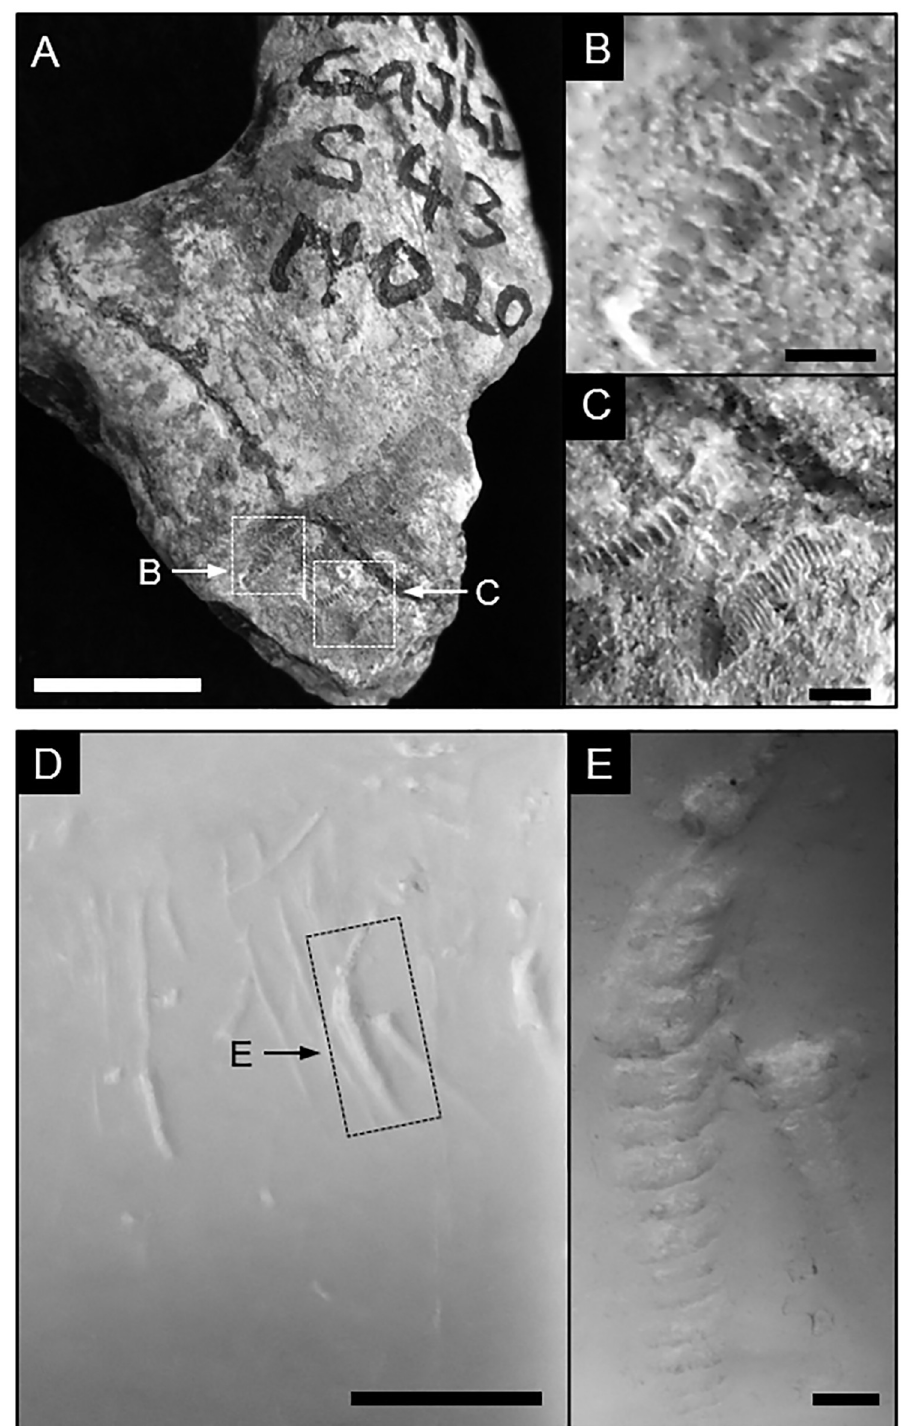
Fig 1. Archived bone fragment (Sample ID—LA91-S43#020) imaged with a digital camera. Sample was recovered from the Lokalalei 1 archaeological site, West Turkana, Kenya, and contains unintentionally induced markings from air-scribe preparation techniques. A) scale bar = 1.0 cm; B, C) scale bars = 1.0 mm. Notice the similarities between these marks and the carnivore-induced tooth scores in Fig 1D and E. D) Carnivore-induced tooth scores and pits on a bovid long bone (Sample 4–2) under a stereomicroscope; scale bar = 1.0 cm. E) Close-up of area highlighted in D; scale bar = 1.0 mm.